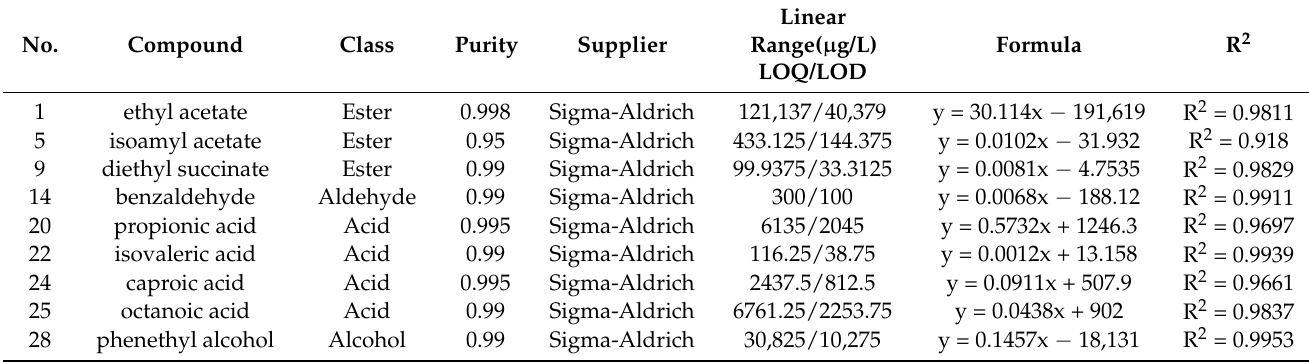
Table 3. Relevant information of the standard curve on vinegar